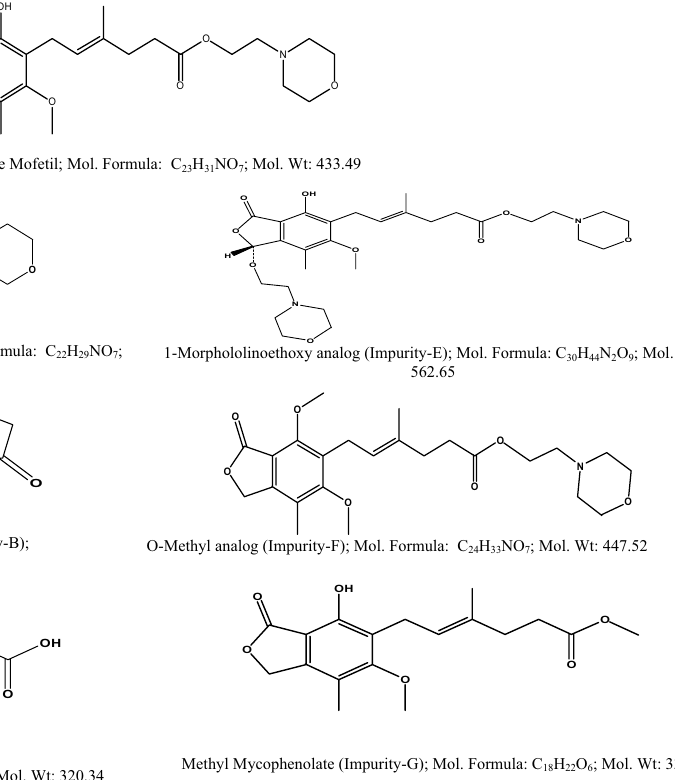
Compound name, Mol. Structure, Mol. Formula and Mol.